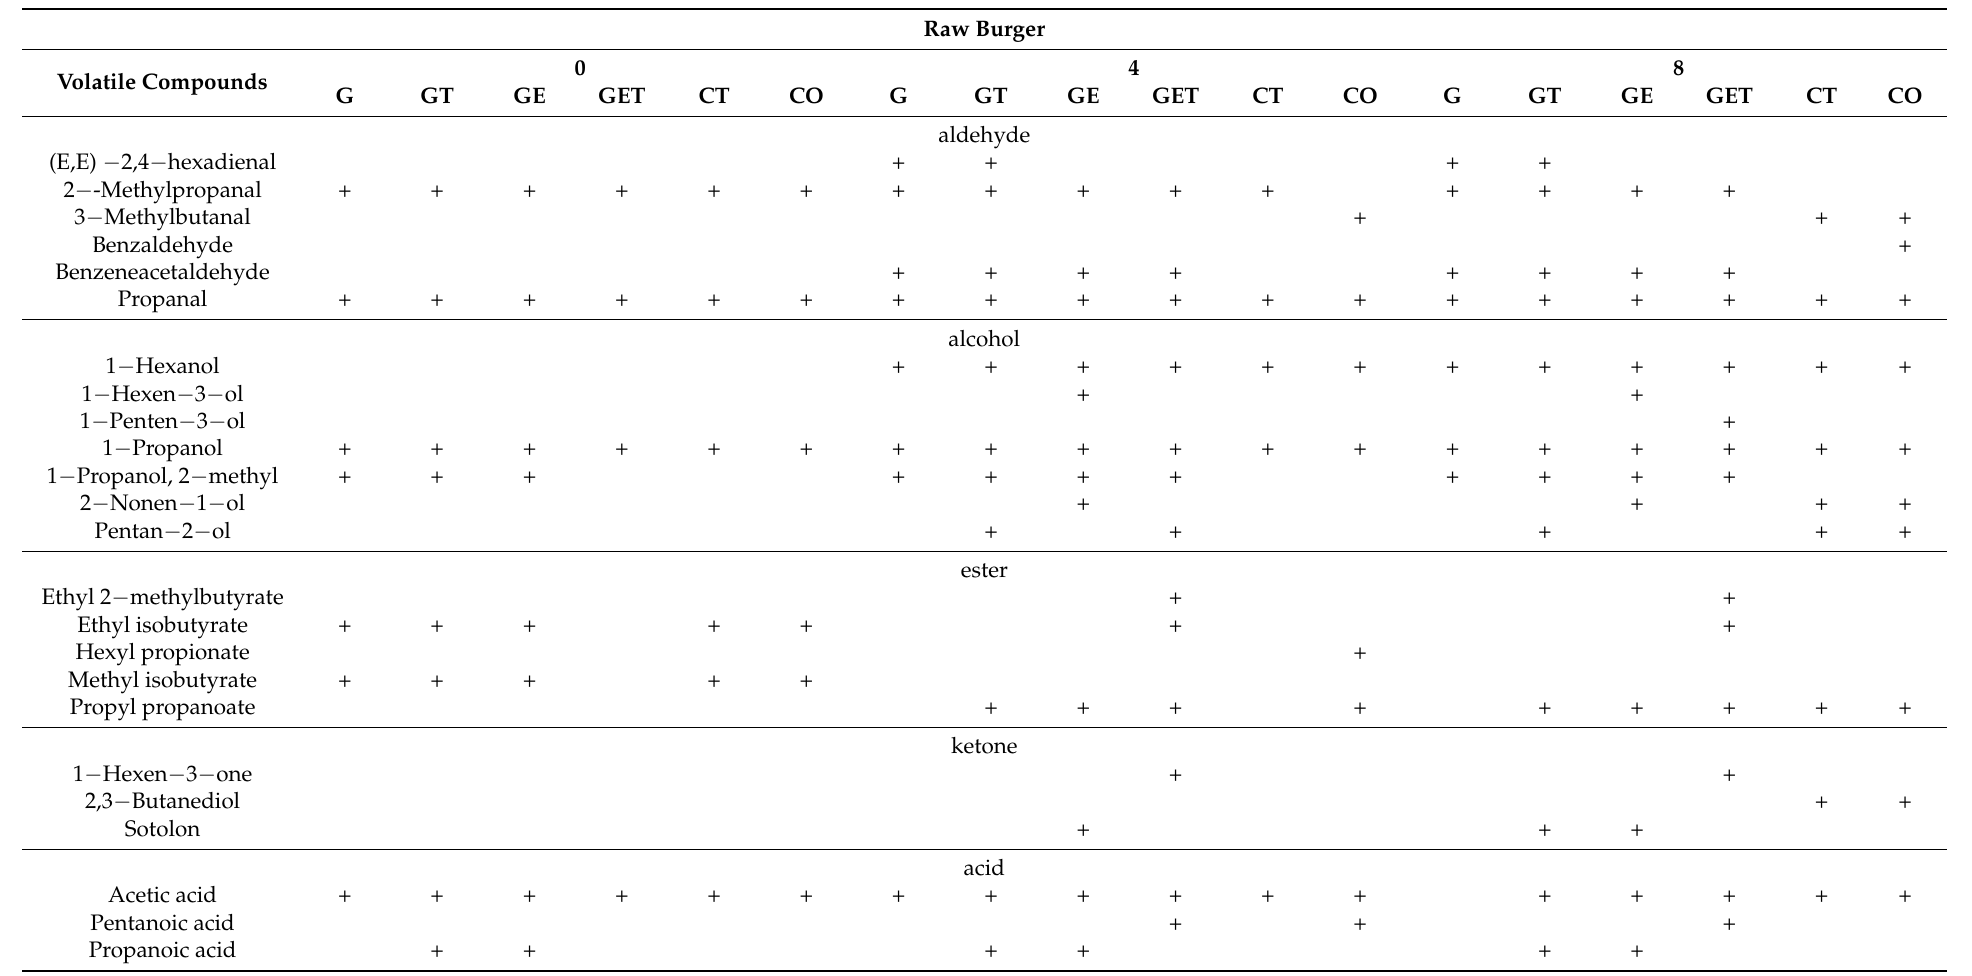
Table 6. Effects of a fat substitute on the volatile compounds profile in raw and grilled burger after 0, 4, and 8 days of storage in cold